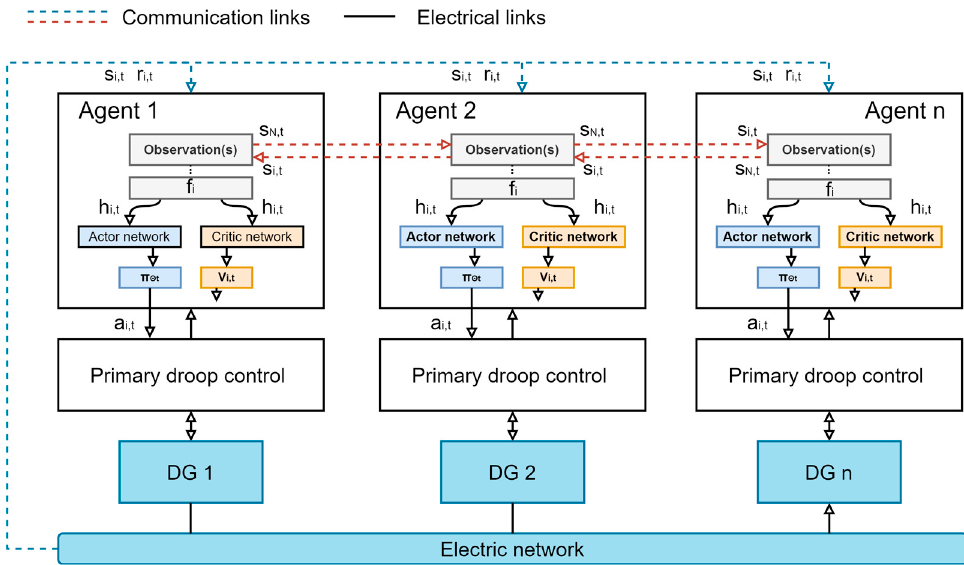
Figure 3. A general diagram of the proposed approach for inverter-based secondary voltage control using the multi-agent reinforcement learning (MARL) structure.